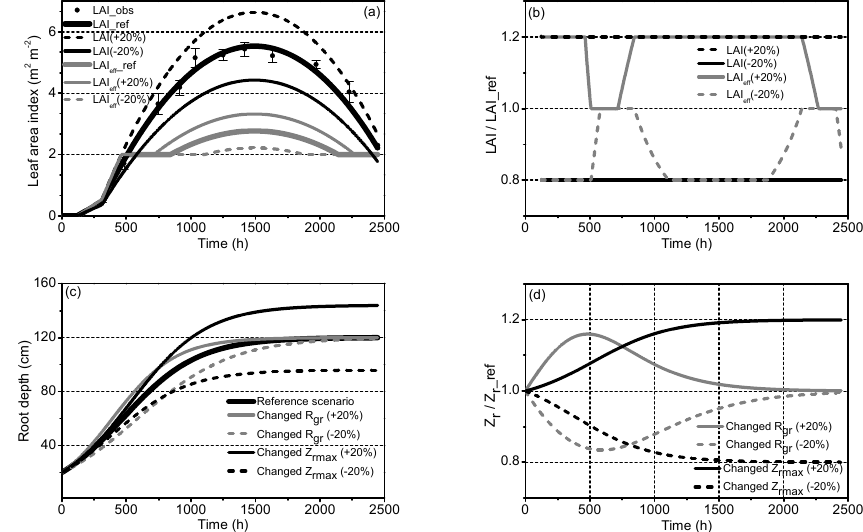
Figure 2. The seasonal variation in crop growth parameters used in the simulations: (a) leaf area index (LAI), (b) relative values of LAI compared to the reference scenario, (c) root depth ( Z r ) , and (d) relative values of root depth compared to the reference scenario; + 20 and − 20% indicate a 20% increase or decrease, respectively, compared to the reference value. The vertical grid lines in (d) highlight the lag effect of the 20% decreased R gr scenario compared to the 20% increased R gr